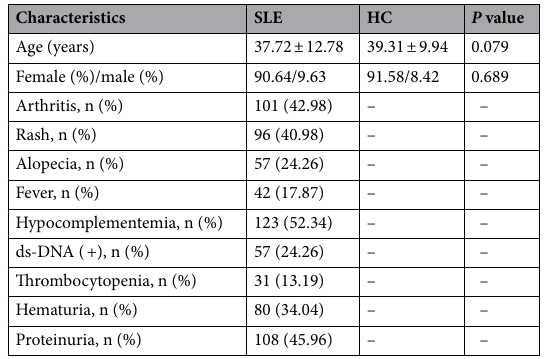
Table 1. Characteristics of SLE patients and controls. SLE, systemic lupus erythematosus; HC, healthy